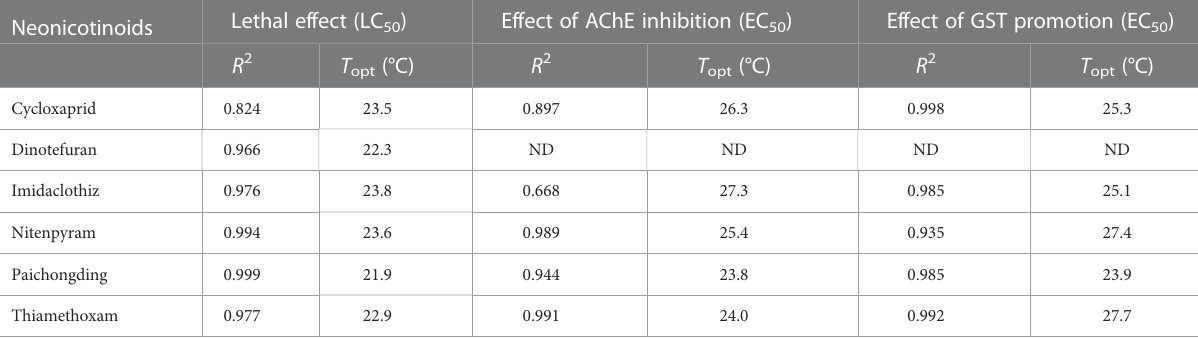
TABLE 3 Effect of temperature on the lethal and sublethal toxicity of neonicotinoids ( R 2 represents the goodness of nonlinear regression curves fi tted by Gaussian distribution in GraphPad Prism (version 5.0, San Diego, CA, USA).